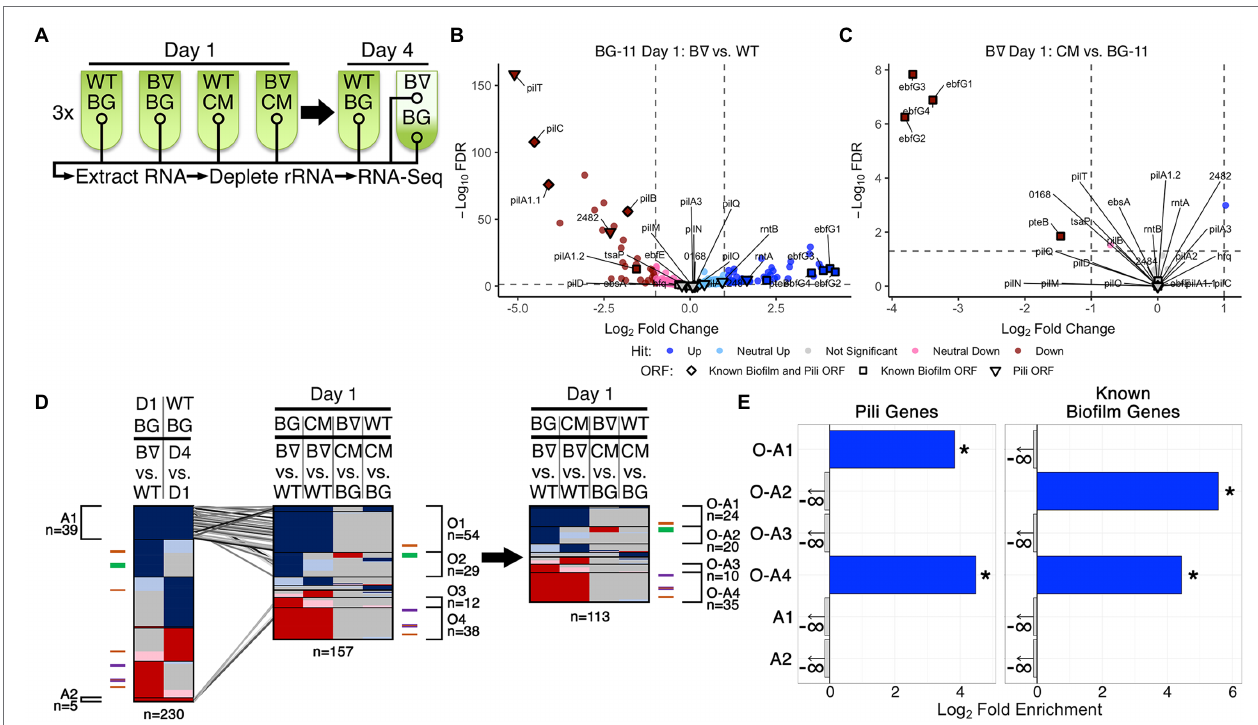
FIGURE 1 | RNA-Seq of WT and PilB ::Tn 5 and Day 1 DEG analysis. (A) Diagram of the time course for triplicate samples processed for Wild Type (WT) and PilB ::Tn 5 (B ∇ ) when placed under biofilm forming conditions in either fresh BG-11 (BG) or WT-derived conditioned media (CM). Samples (circles) include planktonic samples from all test tubes and a sample of the biofilm formed by PilB ::Tn 5 on Day 4 in BG-11. (B,C) Volcano plots comparing the log 2 fold change of pairwise comparisons of samples against their − log 10 false discovery rate (FDR) as calculated by DESeq2. Data points are colored based on their DEG designation (“Hit”). Labeled shapes indicate known biofilm and pili ORFs. Dashed lines indicate the thresholds used for hit designation. Note that each plot is scaled individually. (D) Comparisons of sDEG designations (colored as in B,C ) of ORFs ( y -axis) from different relevant pairwise comparisons, as labeled above. The locations in the graph of known pili and biofilm ORFs are indicated by the colored ticks next to each graph (purple = biofilm and pili ORF, orange = pili ORF, green = biofilm ORF) and clusters of genes with common sDEG patterns across the x -axis of interest are designated with brackets and labeled with their identifiers and the number of sDEGs in the group. The number of ORFs considered in each graph is provided below the graph. On the left, the Day 1 BG-11 PilB ::Tn 5 vs. WT pairwise comparison is compared against the WT BG-11 Day 4 vs. Day 1 comparison to identify ORFs related to the stress or density state of the culture. Those ORFs that are similarly up- or downregulated in these two pairwise comparisons (groups A1 and A2) are connected to their location in the middle graph comparing all relevant Day 1 pairwise comparisons by the diagonal lines. These ORFs were then removed from the middle graph to generate the graph on the right. (E) Enrichment analyses of pili genes and known biofilm genes in the O-A and A groups of interest labeled in (D) . Significant enrichment (FDR ≤ 0.05) is designated by solid bars and stars. Groups that do not have any of the genes analyzed are designated with a negative infinity and arrow, as appropriate for the log 2 scale of the x